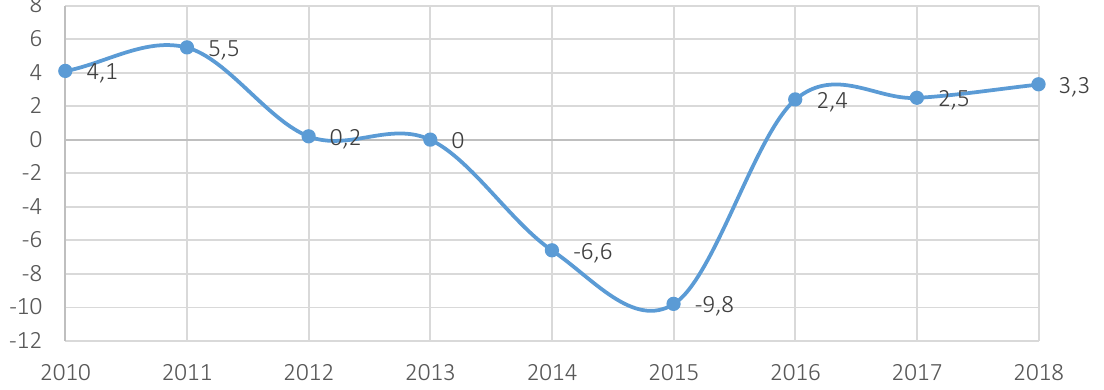
Figure 2. Changes in real gross domestic product (% in the previous